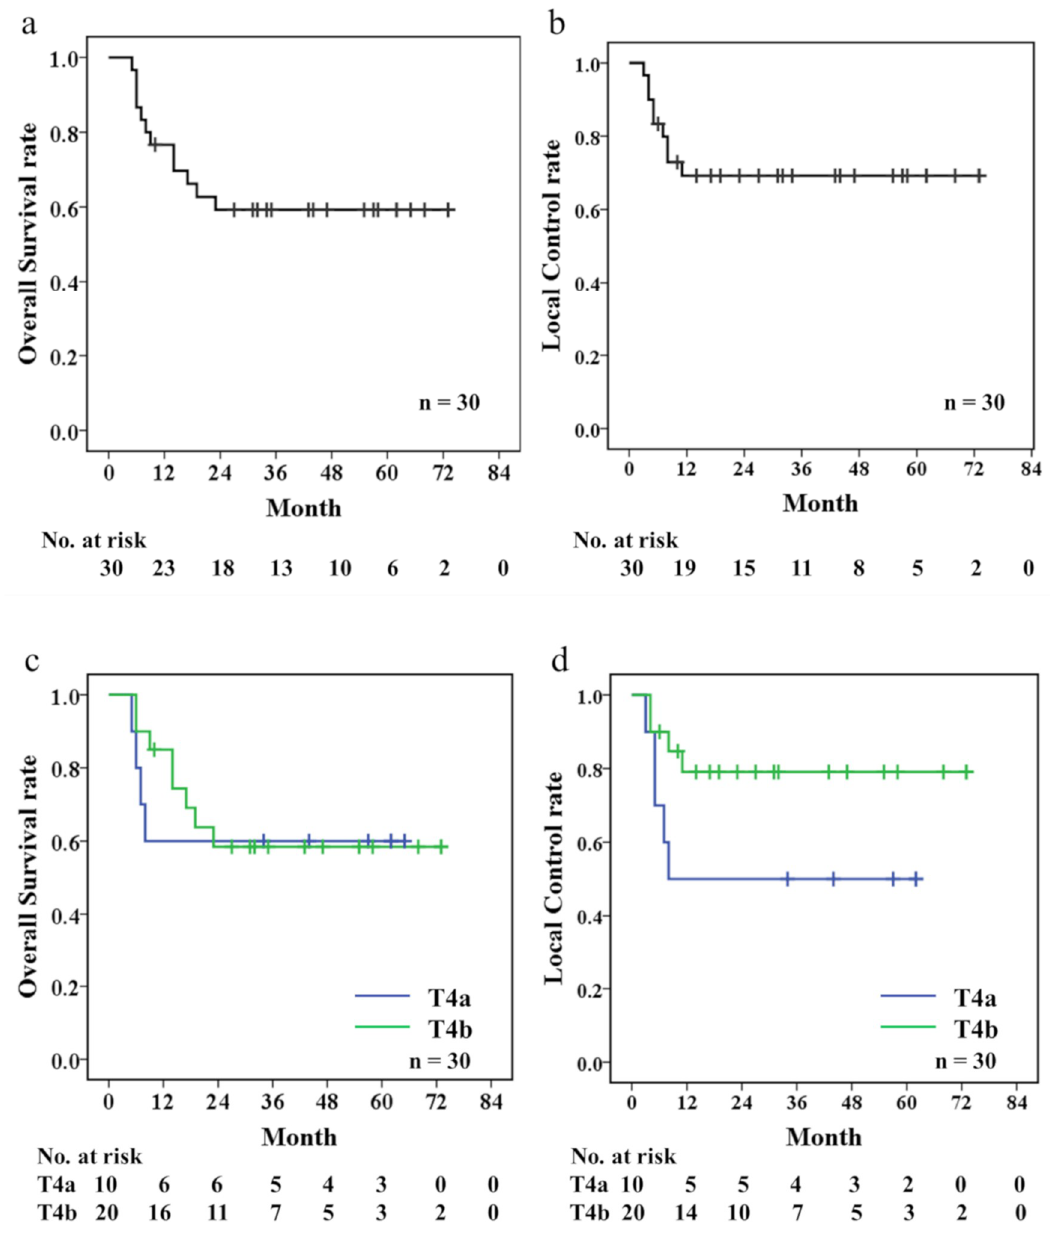
Figure 1. Kaplan-Meier estimates of Overall survival (OS) ( a ), local control (LC) ( b ), Comparisons bet ween T4a and T4b patients to OS ( c ), and LC ( d ).